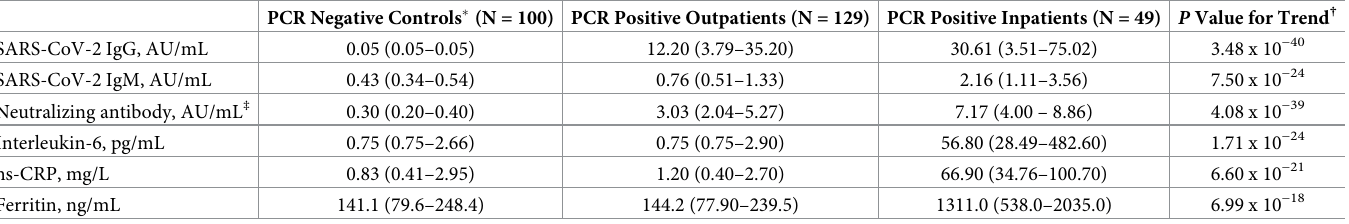
Table 1. Antibody and inflammatory biomarker response in SARS-CoV-2 PCR positive outpatients and PCR positive inpatients vs PCR negative control